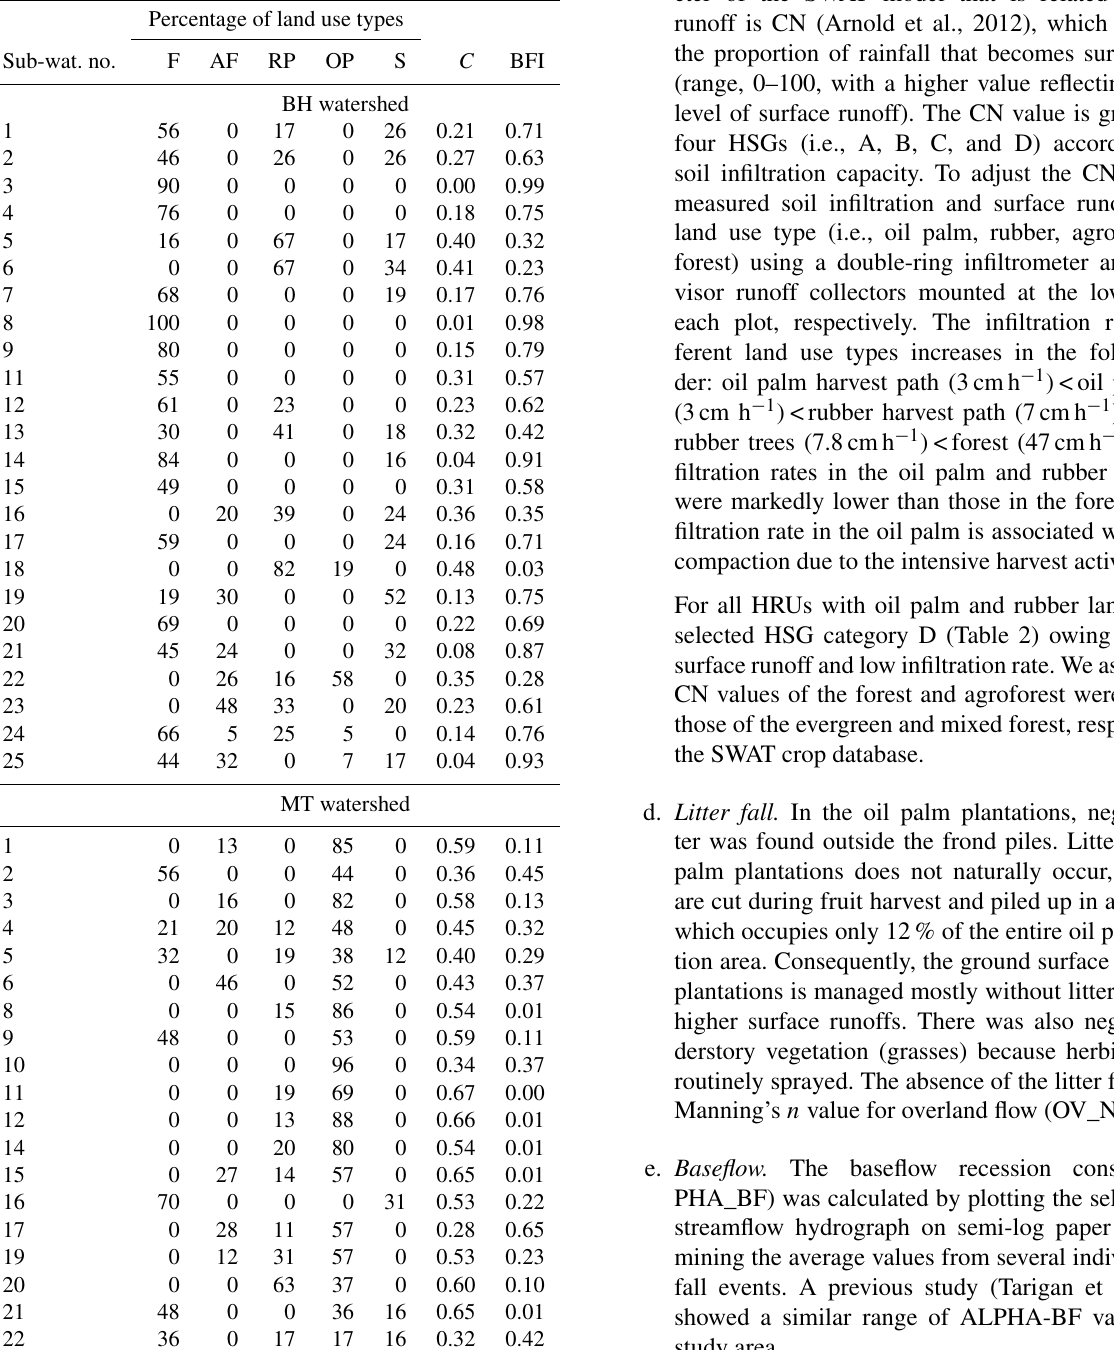
Table 4. The percentage of land use types, C , and BFI in each sub- watershed within the BH and MT